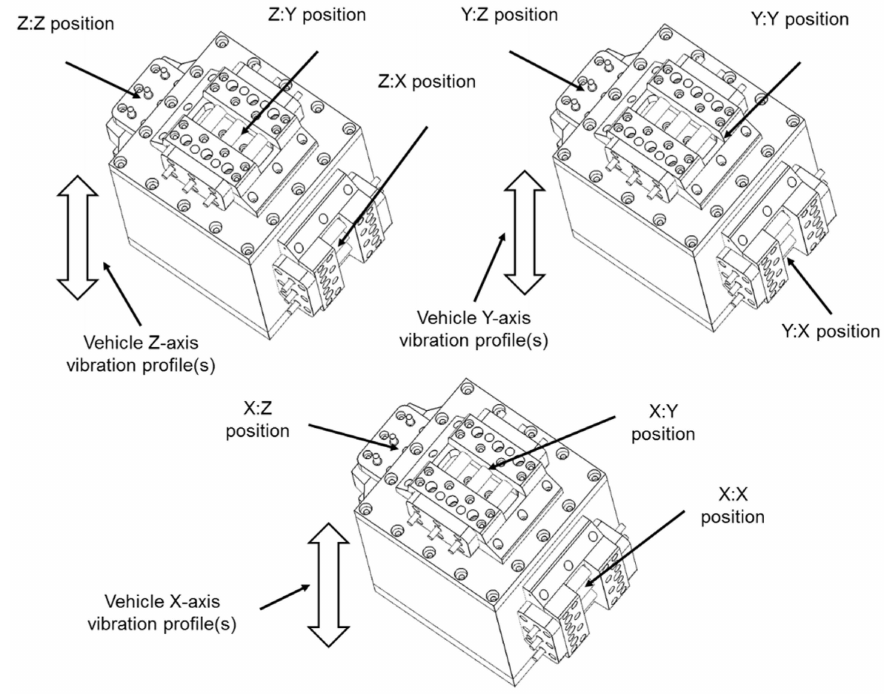
Figure 9. Experimental orientations and test positions on durability